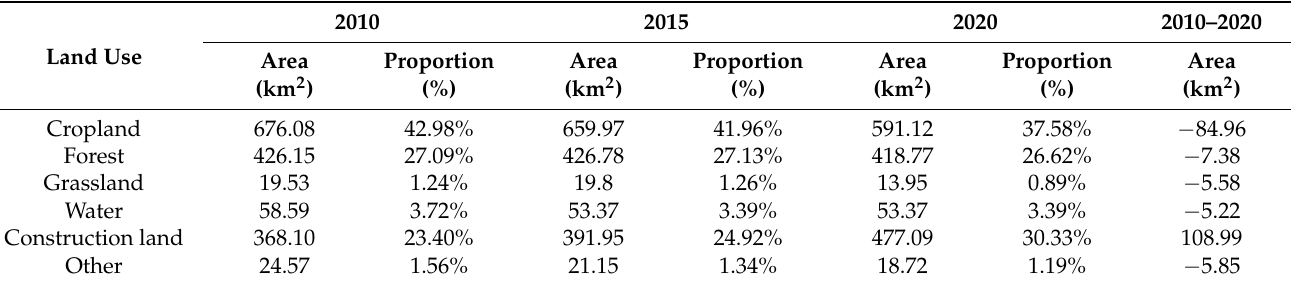
Table 3. LUCC in Xiamen from 2010 to 2020 (unit: km 2 ).